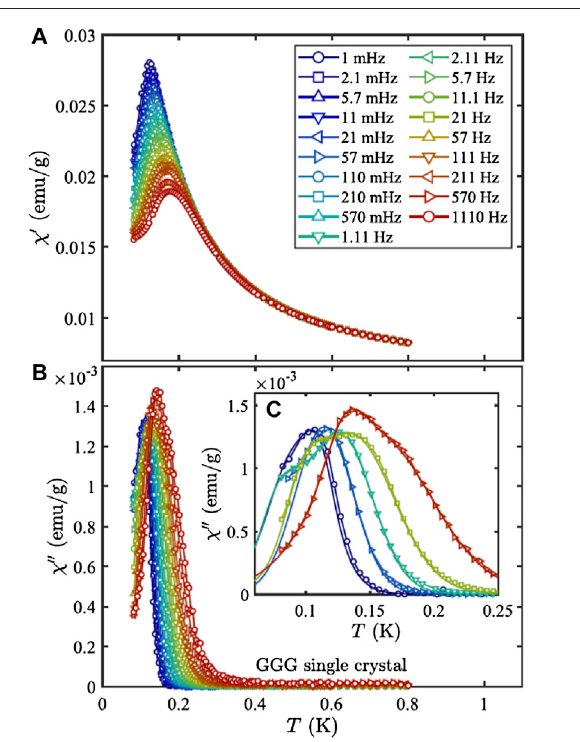
FIGURE 12 | (A) Theoretically calculated, Holstein-Primakoff transformation, neutron scattering intensity for GGG under B = 2.5 T and T = 0.06 K shown as a function of momentum transfer, Q, and energy transfer, E. (B) Inelastic neutron scatering S (Q, ω ) (Ei = 1.28 meV) of GGG with B = 2.5 T and T = 0.06 (K) . The feature at 0.25 Å − 1 is an experimental spurion.